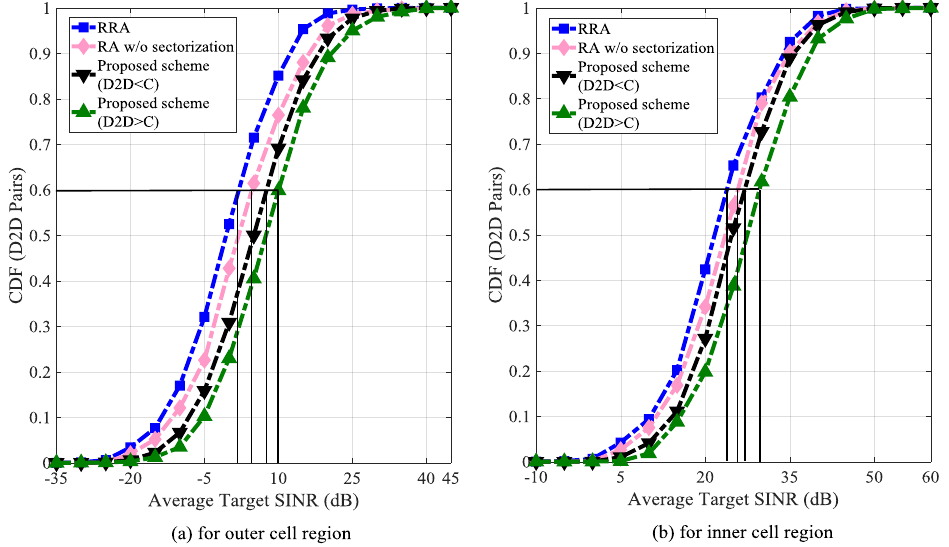
Figure 5. Average target signal-to-interference-plus-noise ratio (SINR) vs. cumulative distribution function (CDF) for D2D pairs, ( a ) outer cell region, ( b ) inner cell region.